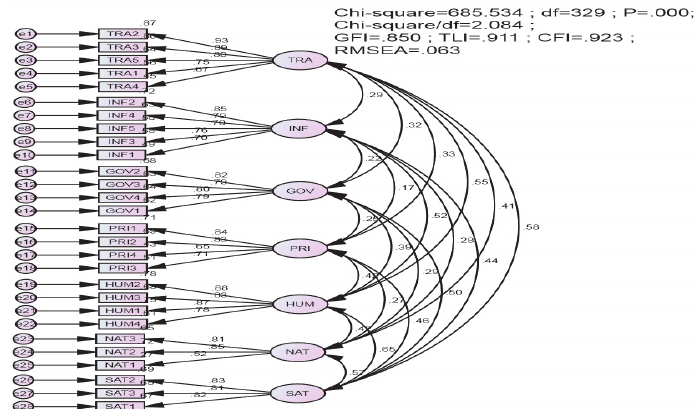
Fig. 2. Results of CFA of the organizational culture scale (standardized)